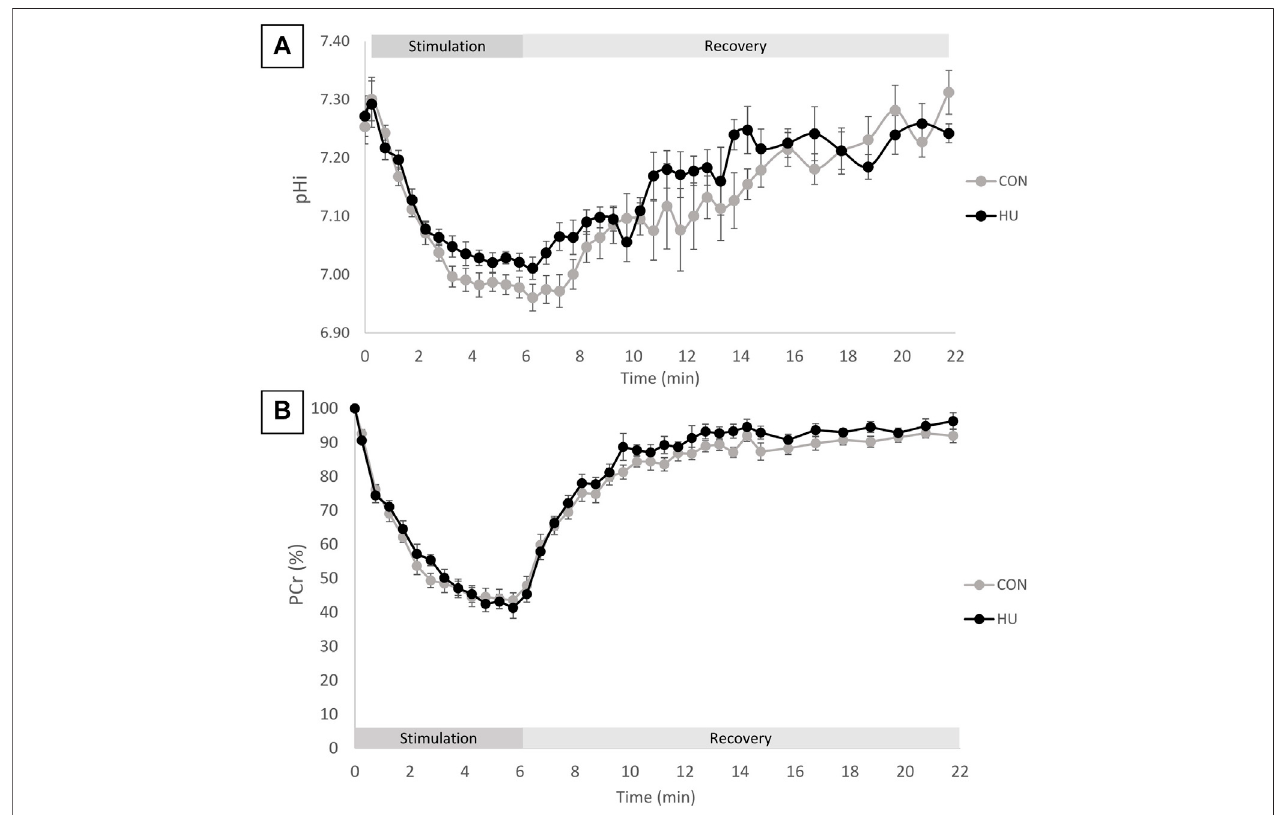
FIGURE1|(A) pHitimecourseduringtherest-stimulation-recoveryprotocolinCONandHU.Resultsarepresentedasmeans±SEM. (B) RelativePCrtime-course during the rest-stimulation-recovery protocol in CON and HU. Results are presented as means ± SEM.